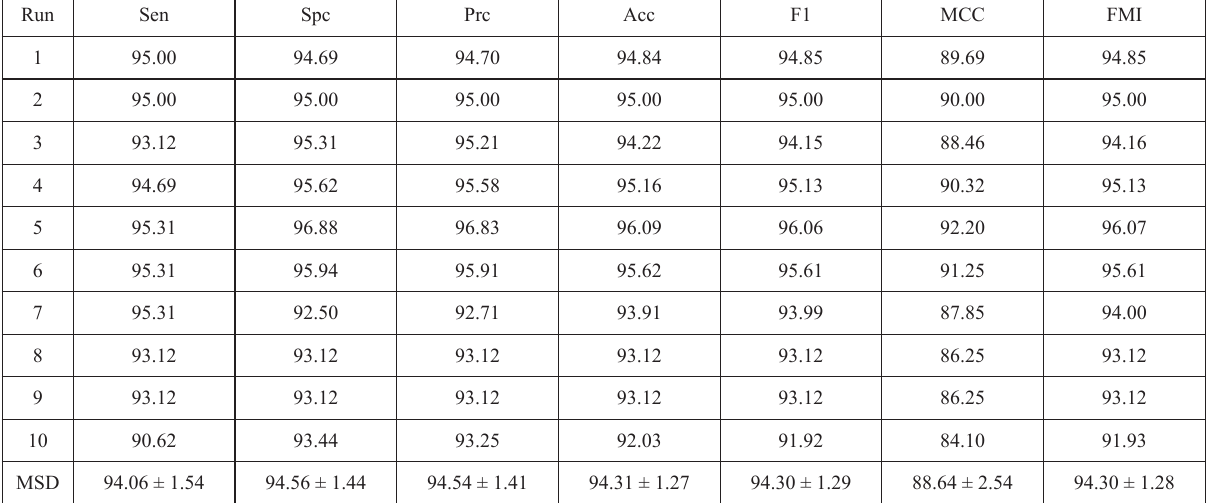
Table 9. Experimental results using max